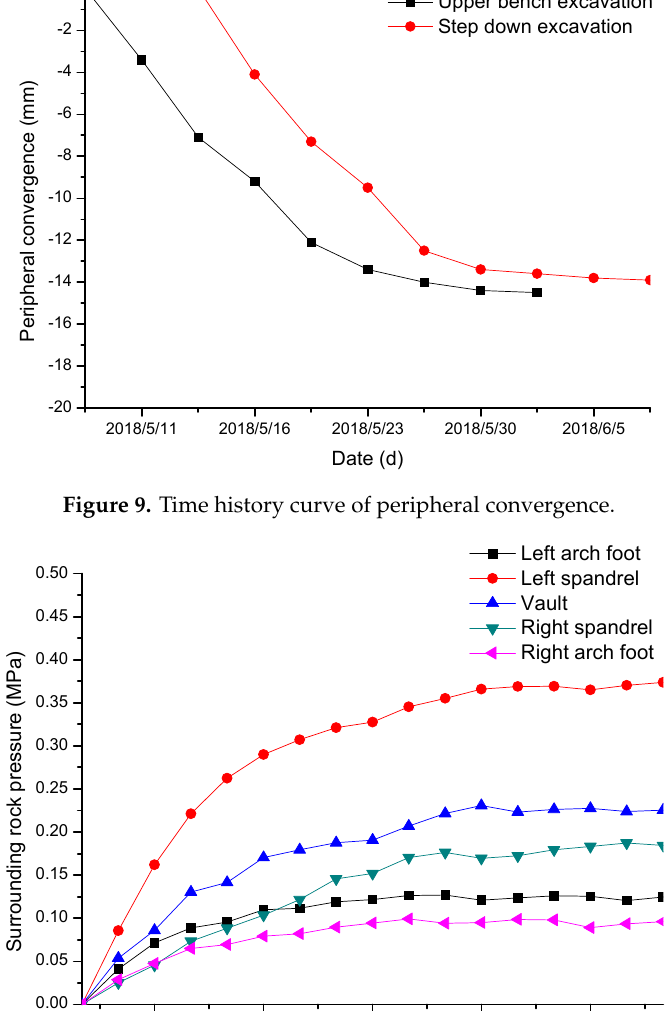
Figure 8. Settlement time history curve of arch crown.